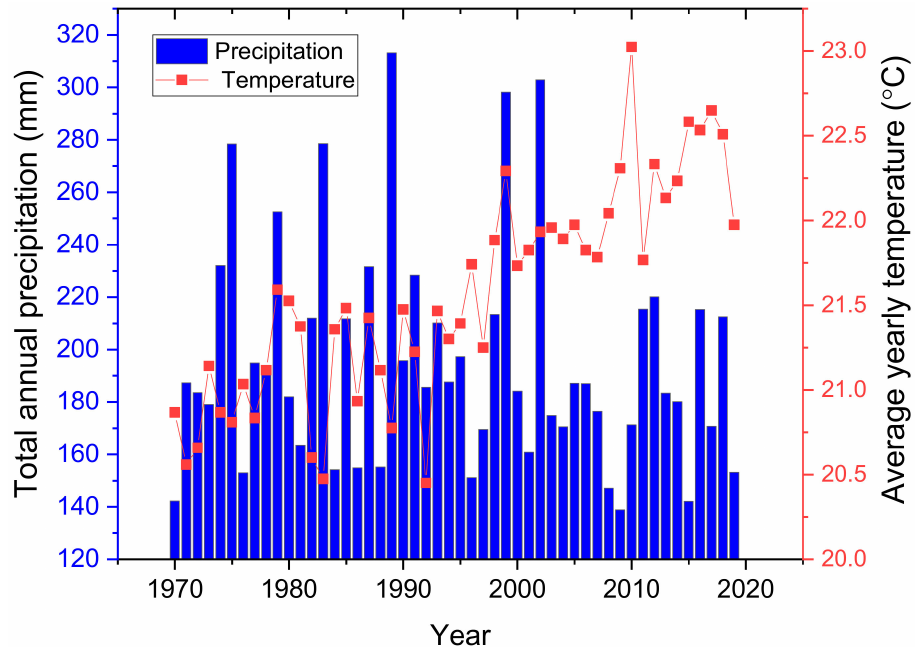
Figure 2. The study area’s yearly average precipitation and